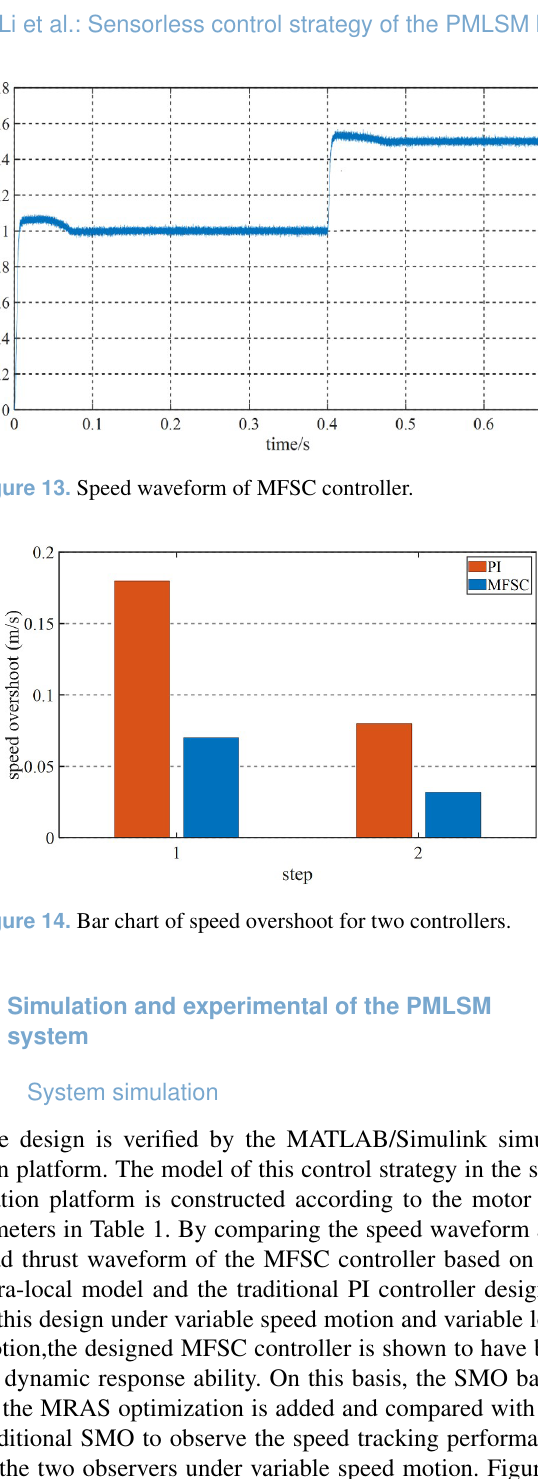
5 Simulation and experimental of the PMLSM system